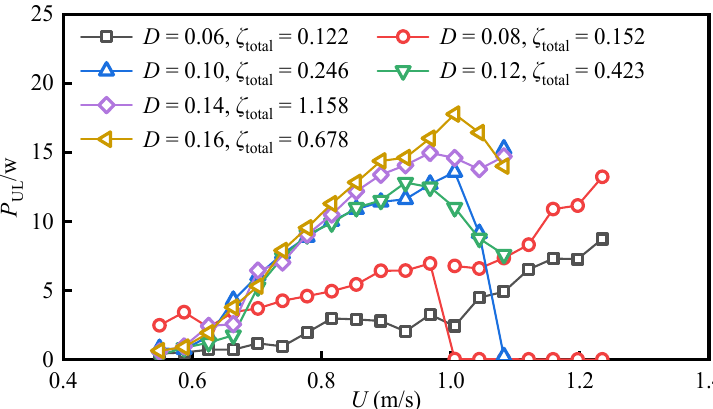
Figure 19. Variation of maximum power output versus velocity at various Reynolds numbers.